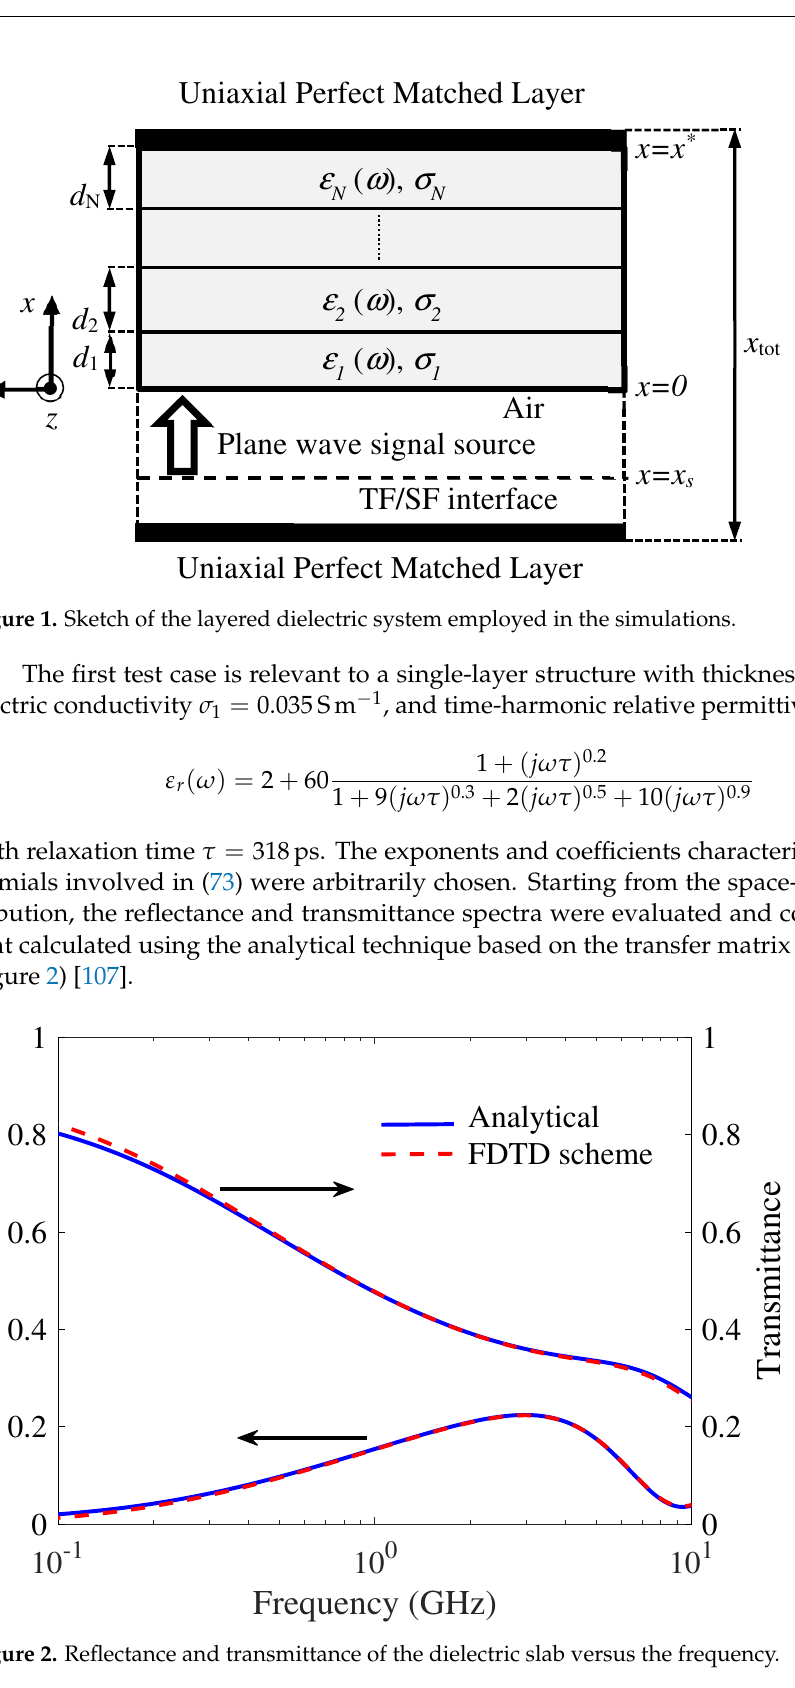
Figure 2. Reflectance and transmittance of the dielectric slab versus the